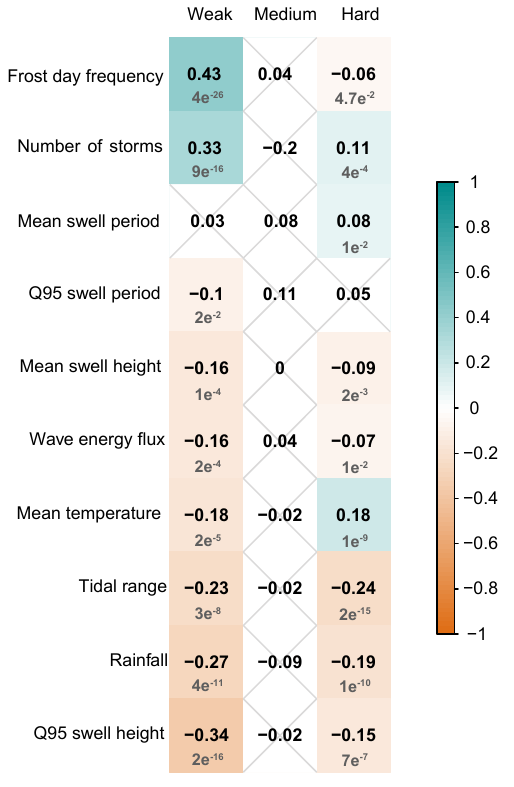
Figure 8. Spearman rank correlation matrix between forcing and erosion rate for the three types of rock resistance. Values in black are Spearman correlation coefficients. Grey values are the associated p values, which were only reported when significant ( < 0 .